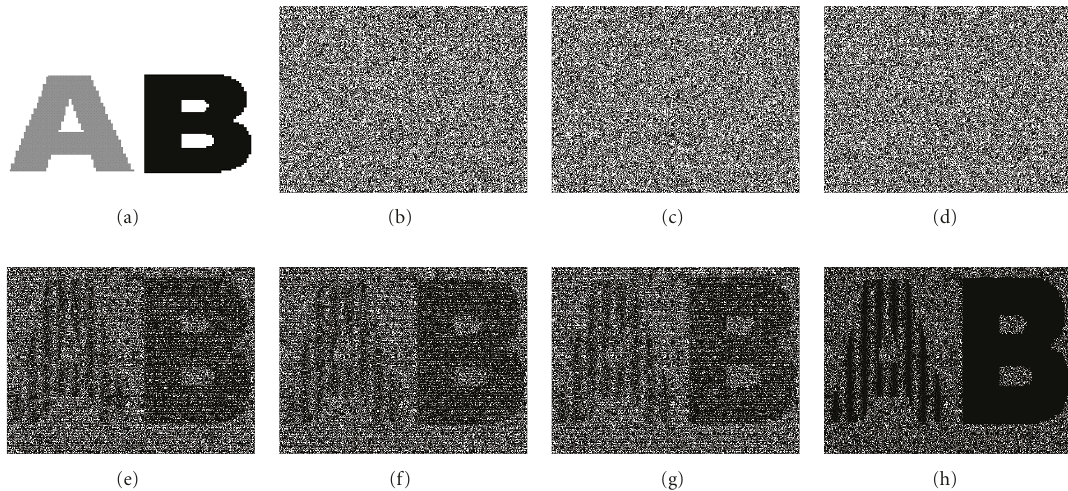
Figure 1: (a) The secret image. (b) Share 1. (c) Share 2. (d) Share 3. (e) Share 1+Share 2. (f) Share 1 + Share 3. (g) Share 2 + Share 3. (h) Share 1 + Share 2 + Share